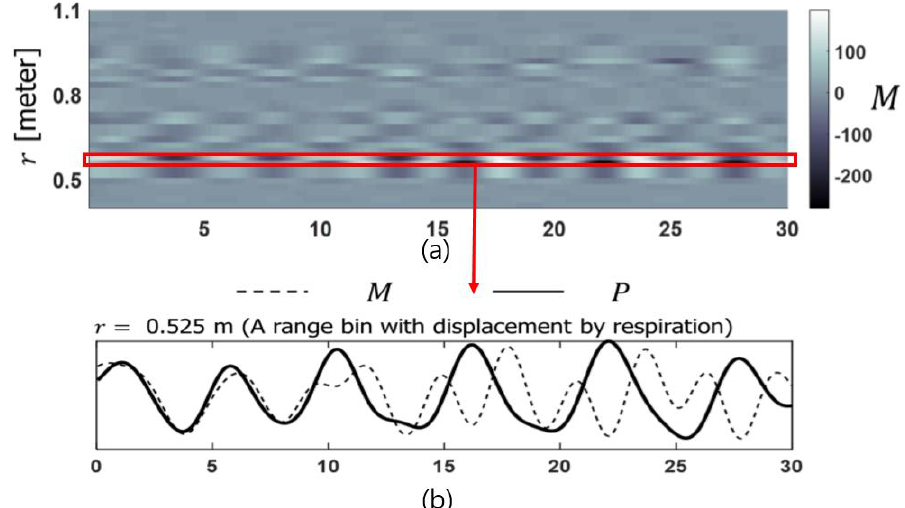
Figure 2. Radar signal extracted for respiration measurement. ( a ) The magnitude 𝑀(𝑡, 𝑟 𝑘 ) at various distances 𝑟 𝑘 , ( b ) the magnitude change in 𝑟 𝑘 = 0.525 𝑚 according to the chest’s up and down movement.